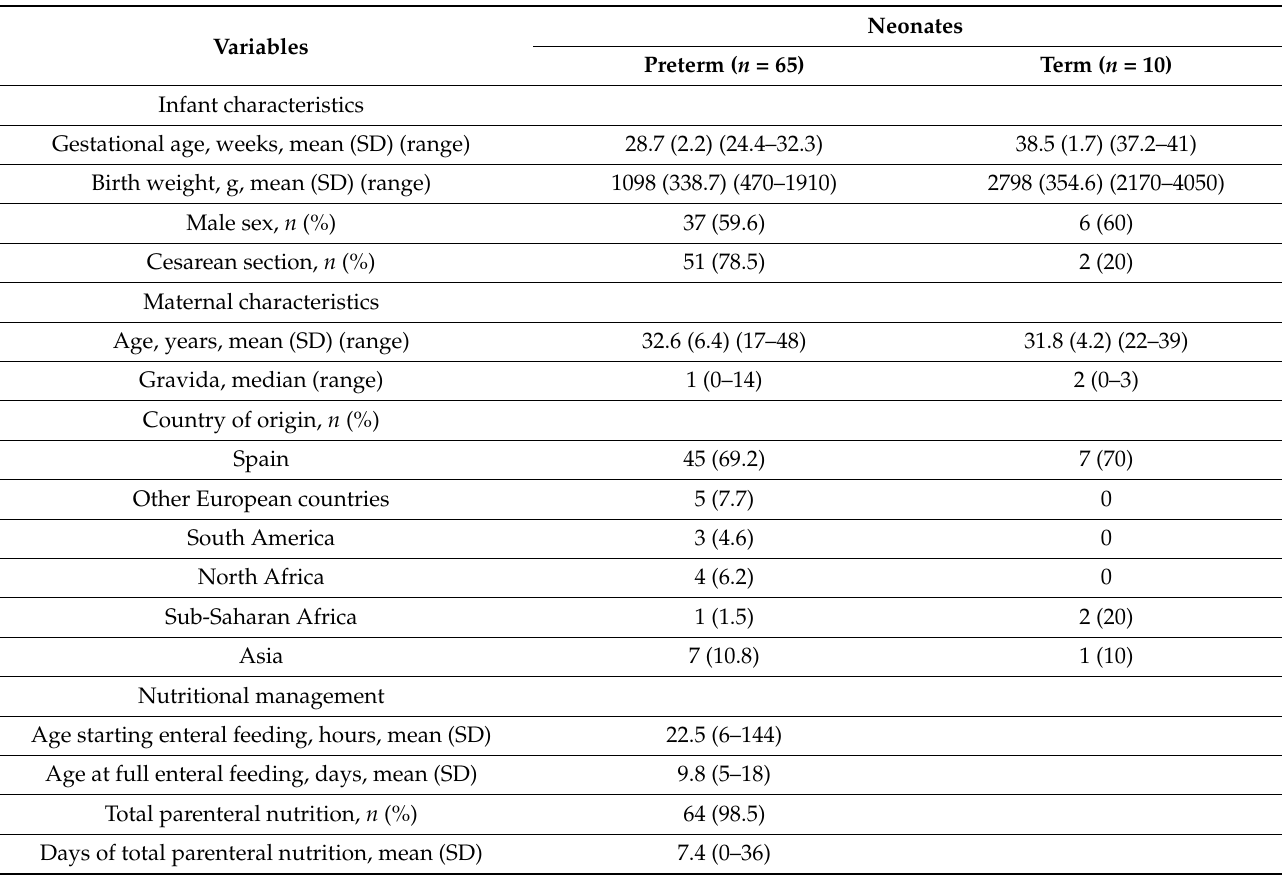
Table 1. Infant and maternal characteristics of preterm neonates and infants at term.